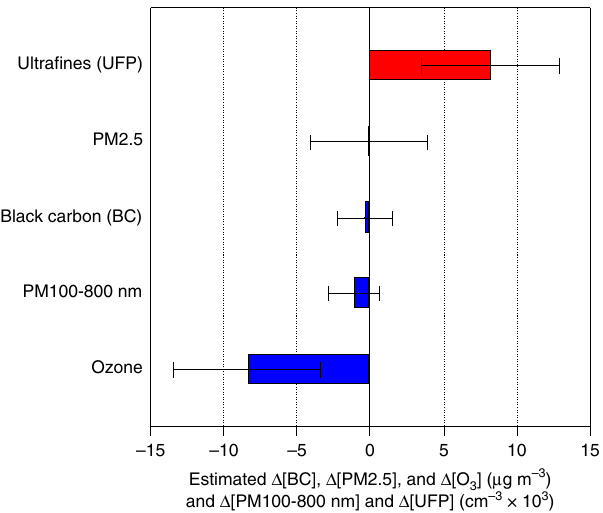
Fig. 3 Sensitivity to diesel control for changes in pollutant concentrations. For varying composition, size range, and time-of-day window, in the São Paulo metropolitan area as the gasoline share in the fl ex-fuel fl eet rises from 30 to 80 percentage points. Submicron particles and BC correspond to readings at 08:00, PM2.5 are 24-h means, and ozone are afternoon means between 12:00 and 16:00. Sample periods are January to May 2011 for submicron particles, October 2010 to April 2011 and October to November 2012 for BC, and November 2008 to May 2013 for PM2.5 and ozone. 95% CI are shown. Source: Speci fi cations reported in Table 2 additionally controlling for monthly diesel bus ridership in the metropolis ’ public transportation system (Supplementary Fig.